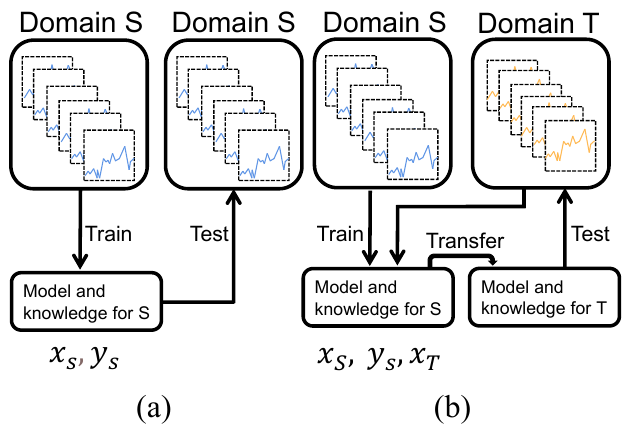
Figure 1. ( a ) Traditional neural network prediction scenarios. ( b ) Unsupervised domain adaption